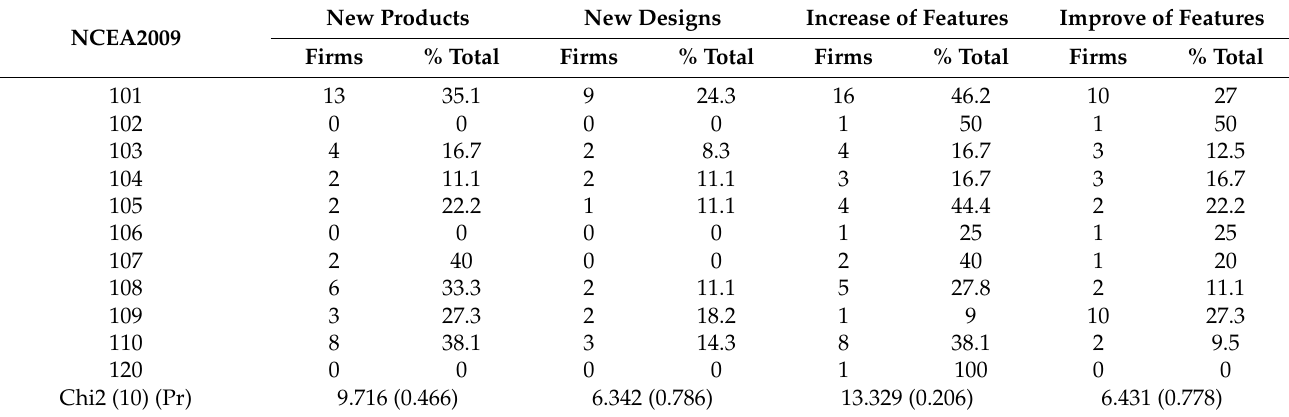
Table 7. Changes made to products according to the branch of